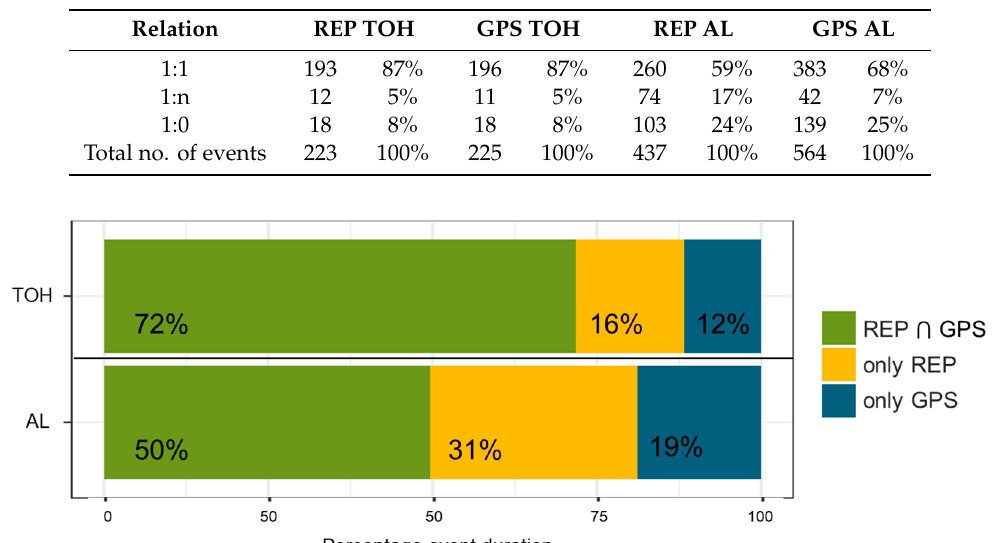
Table 6. Number of valid events with one match (1:1), multiple matches (1:n), no match (1:0).